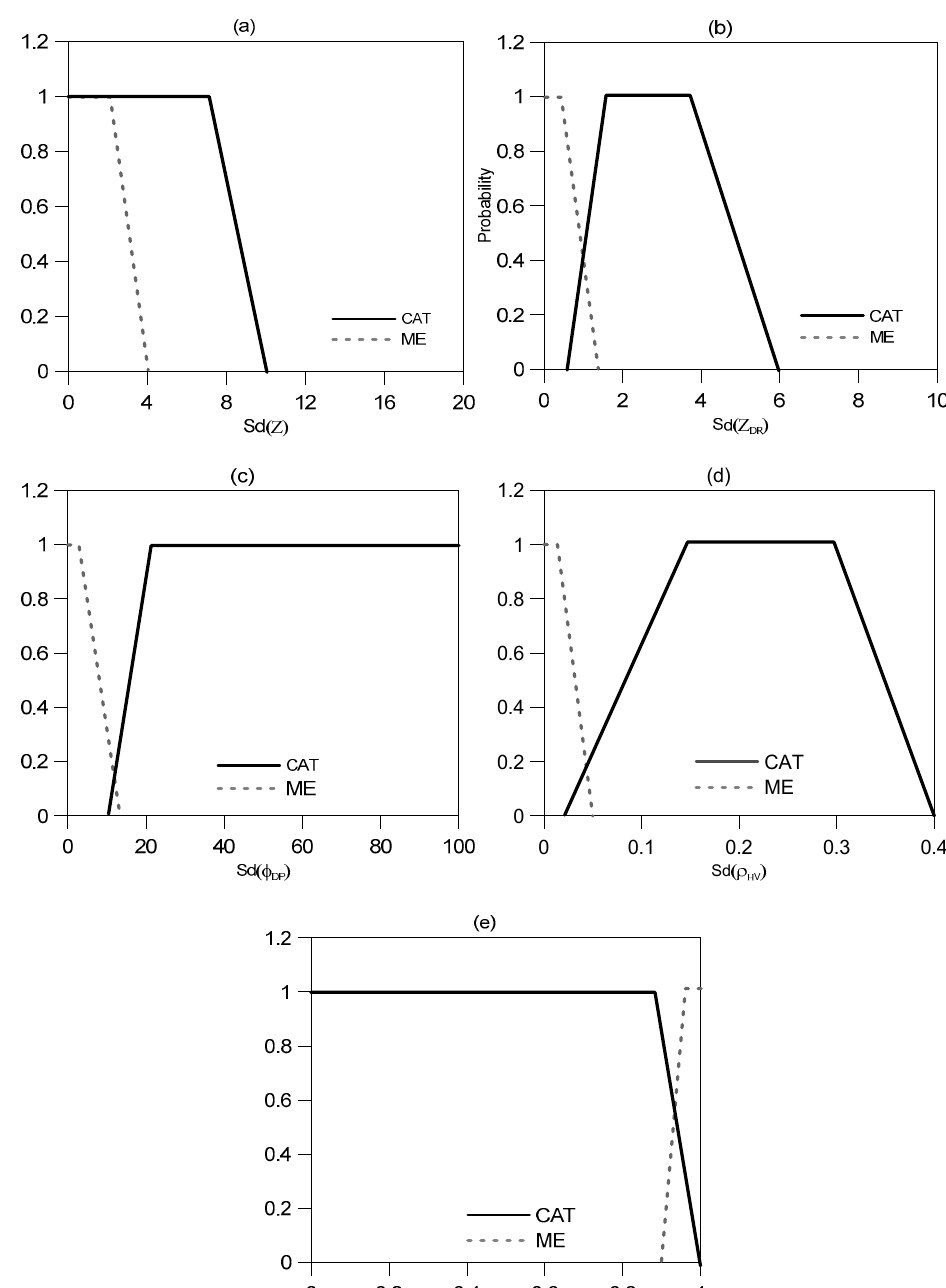
Figure 10. Membership functions of CAT and ME for ( a ) Sd (Z), ( b ) Sd (Z DR ), ( c ) Sd ( Φ DP ), ( d ) Sd ( ρ HV ), and ( e ) ρ HV .